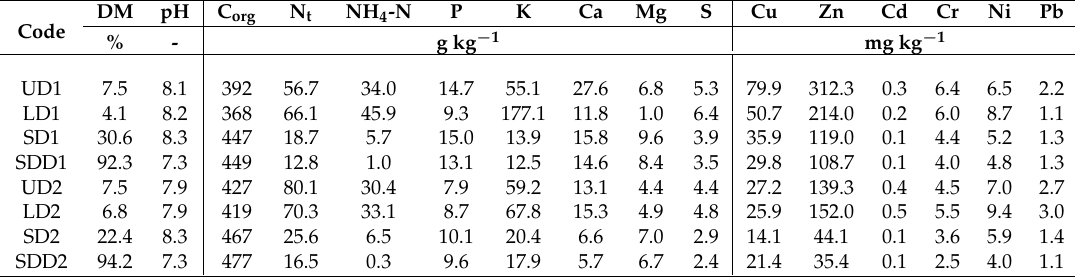
Table 2. Chemical composition of digestate variants, values based on DM (code see Table 1).